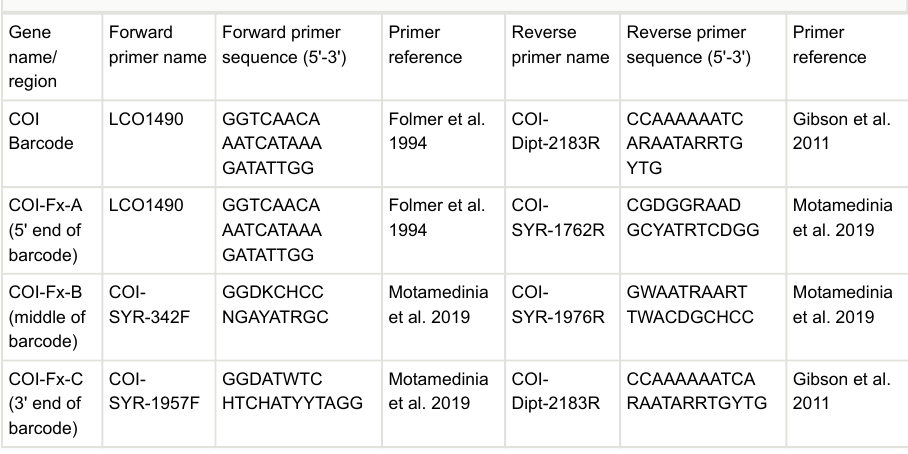
Cytochrome c oxidase subunit I mitochondrial gene